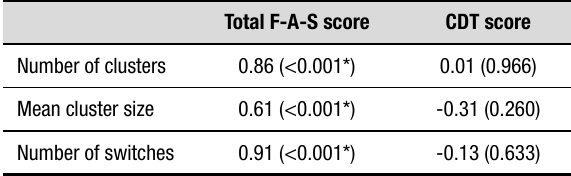
Table 3. Correlations among the scores for number of clusters, mean cluster size, and number of switches and the total scores for the F-A-S test and clock drawing